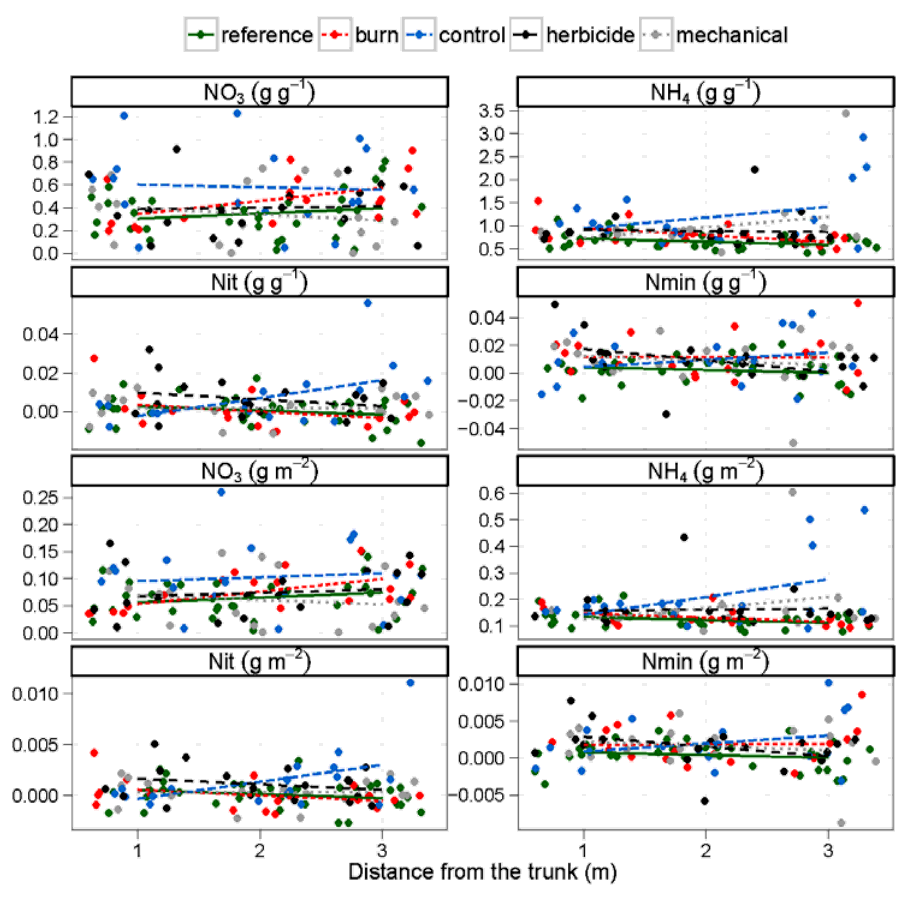
Figure 2. Relationships between inorganic nitrogen and distance from the trunk of longleaf pine ( Pinus palustris ) trees (n = 36) at EAFB, Florida. Please note that jitter points were used to ovoid overplotting. Values are presented on a dry soil mass basis ( i.e. , g g − 1 ) and volume basis ( i.e. , g m − 2